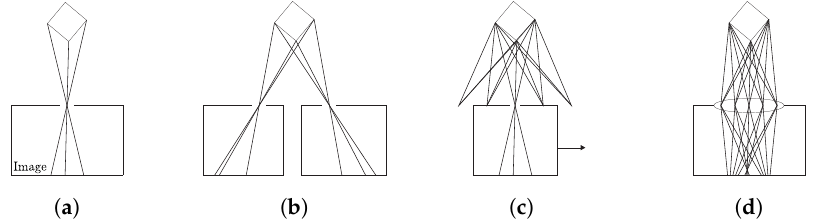
Figure 2. Different pinhole camera image acquisition; ( a ) Shows a single pinhole camera image acquisition; ( b ) Stereo image acquisition with two viewpoints; ( c ) Sequential image acquisition by a motion parallax system; ( d ) Iillustrates how a lens would collect light from a variety of view points (adapted from [24]).